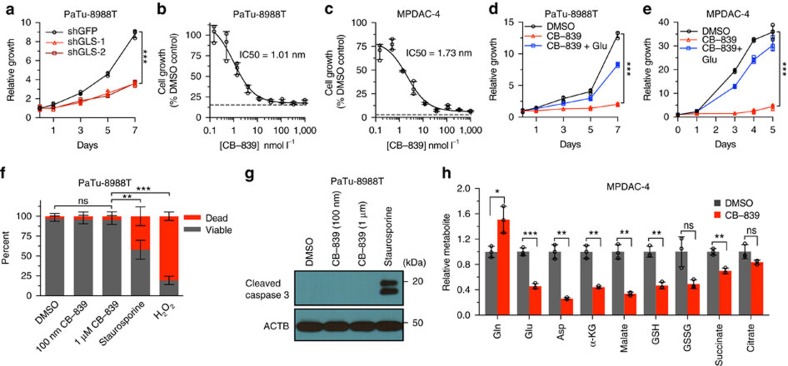
GLSi with CB-839 has antiproliferative activity in PDAC cell lines.(a) Relative proliferation of PaTu-8988T cells expressing a control shRNA or shRNAs to GLS (#1 and #2). Data are plotted as relative cell proliferation in arbitrary units. Error bars depict±s.d. of three independent wells from a representative experiment (of four experiments). (b,c) Cell proliferation dose–response curves for PaTu-8988T (b) and MPDAC-4 (c) treated with CB-839 for 72 h. The dashed line indicates the relative reporter signal at the time of CB-839 addition. Error bars depict±s.d. of three independent wells from a representative experiment (of three experiments). (d,e) Relative proliferation of PDAC cell lines, PaTu-8998T (d) and MPDAC-4 (e) treated with CB-839 (100 nm) or DMSO. As indicated, glutamate (Glu, 4 mM) was added to the media at the time of CB-839 addition. Error bars depict±s.d. of three (d) or four (e) independent wells from a representative experiment (of four experiments). (f) PaTu-8988T cell viability as determined by trypan blue exclusion assay at 72 h after DMSO and CB-839. Staurosporine (1 μm) and H2O2 (1 mM) positive controls treated for 3 h. Data are represented as mean±s.d. of three independent wells from a representative experiment (of four experiments). (g) Cleaved Caspase-3 western blotting analysis of extracts from PaTu-8988T cells at 72 h after DMSO or CB-839. Staurosporine positive controls treated for 3 h. (h) Relative metabolite abundance in MPDAC-4 cells following 6 h CB-839 treatment. Data are presented as mean total metabolite pools±s.d. of three independent wells from a representative experiment (of three experiments). For all panels, significance determined with t-test. *P<0.05, **P<0.01, ***P<0.001, ns: non-significant, P>0.05.